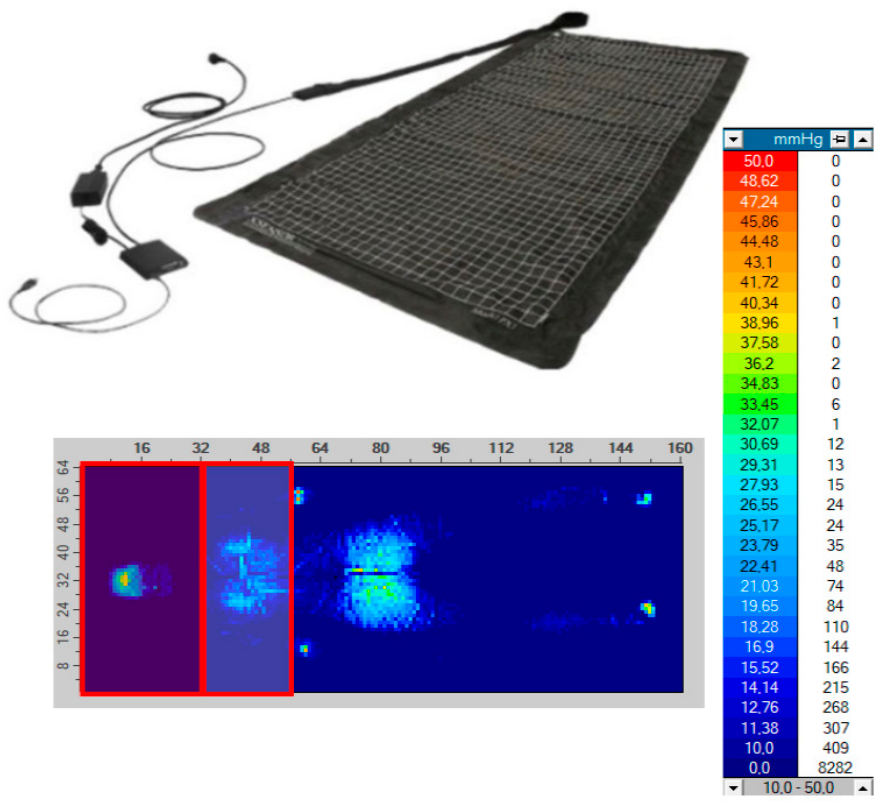
Figure 3. Pressure-mapping blanket ( upper panel) and pressure distribution map ( lower panel). Upper panel: The X3 R&D Mattress System is a full body pressure mapping blanket used to accurately test mattresses and mattress components. This blanket consists of 10,240 sensing points. The ComfortMap image shows how well a mattress conforms to a patient’s body, and the curve illustrates pressure distribution. For analyzing the pressure distribution, pressure was measured in mmHg and recorded from each sensing point for each participant in each group.